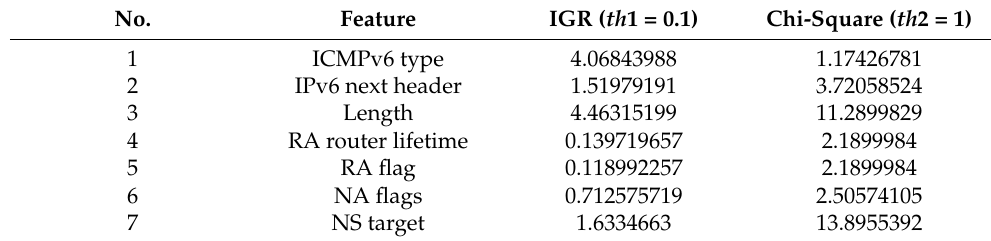
Table 5. Selected features by IGR and